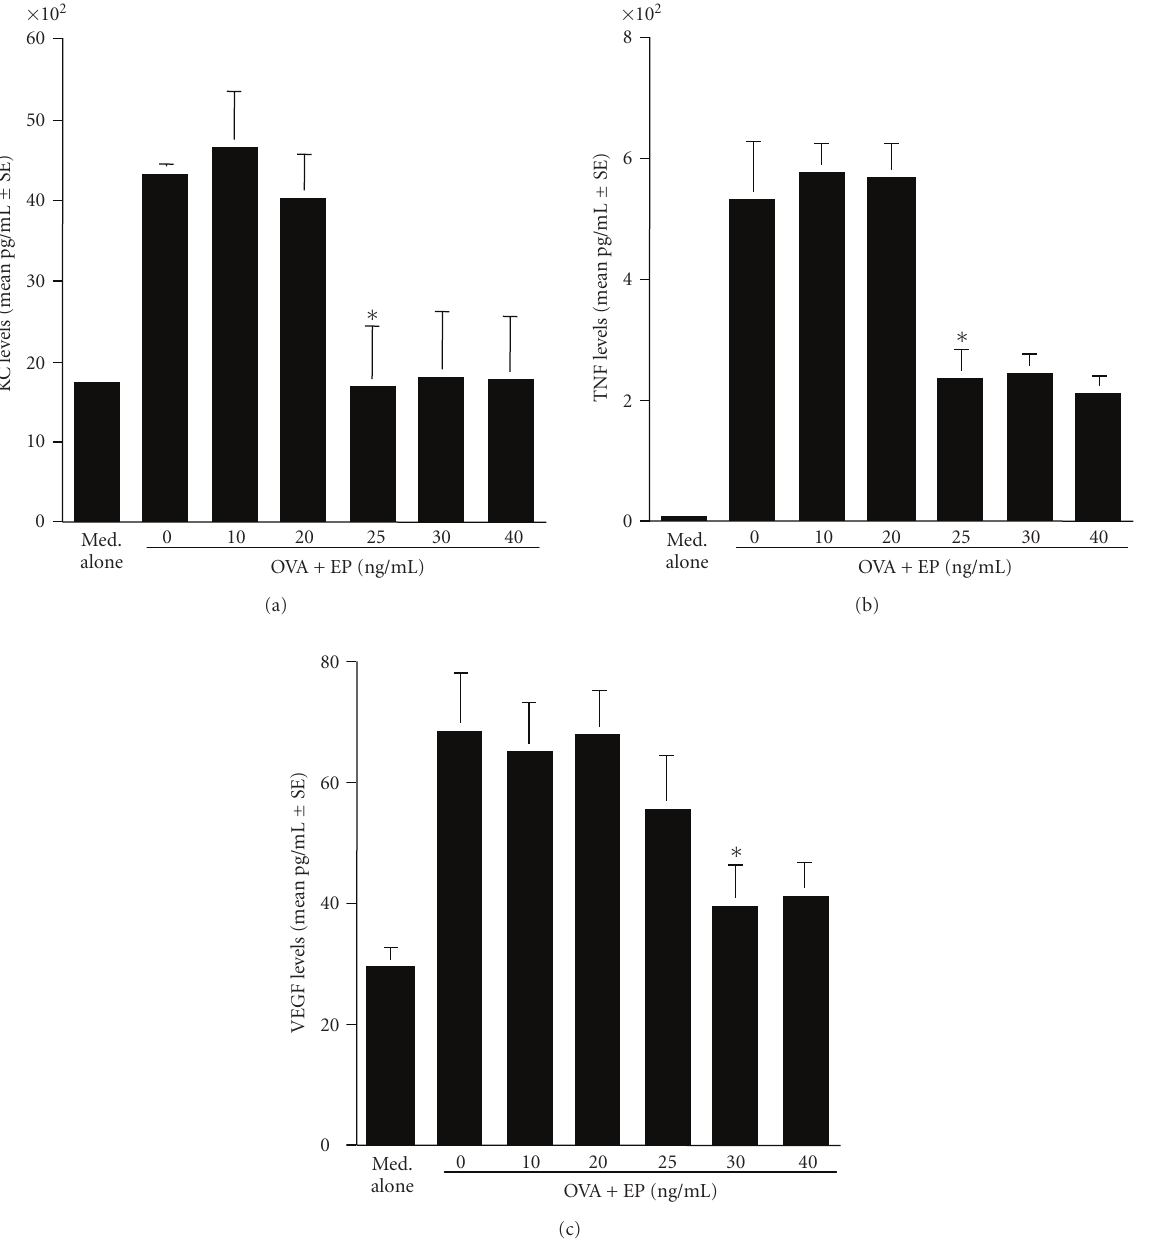
Figure 1: Suppressive activity of epinastine hydrochloride (EP) on angiogenic factor production from mast cells in IgE-dependent mechanism. Murine peritoneal mast cells (5 × 10 5 cells/mL) sensitized with IgE specific for ovalbumin (OVA) were stimulated with 10ng/mL OVA in the presence of various concentrations of EP for 4 hours. The levels of angiogenic factors in culture supernatants were analyzed by ELISA. The data were expressed as the mean pg/mL ± SE of triplicate cultures. KC: keratinocyte-derived chemokine (a); TNF: TNF- α (b); VEGF: vascular endothelial growth factor (c); ∗ P < . 05 versus control (EP at 0